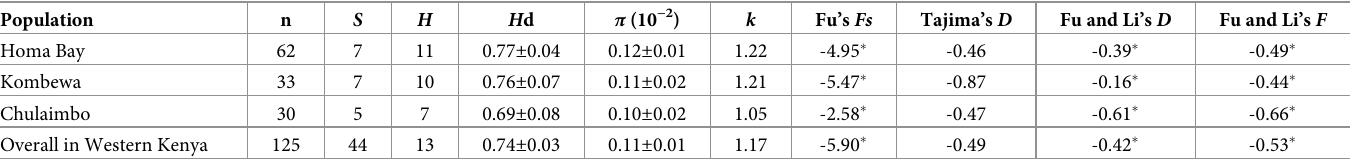
Table 1. Genetic diversity indices and neutrality tests based on Pfs47 sequences.